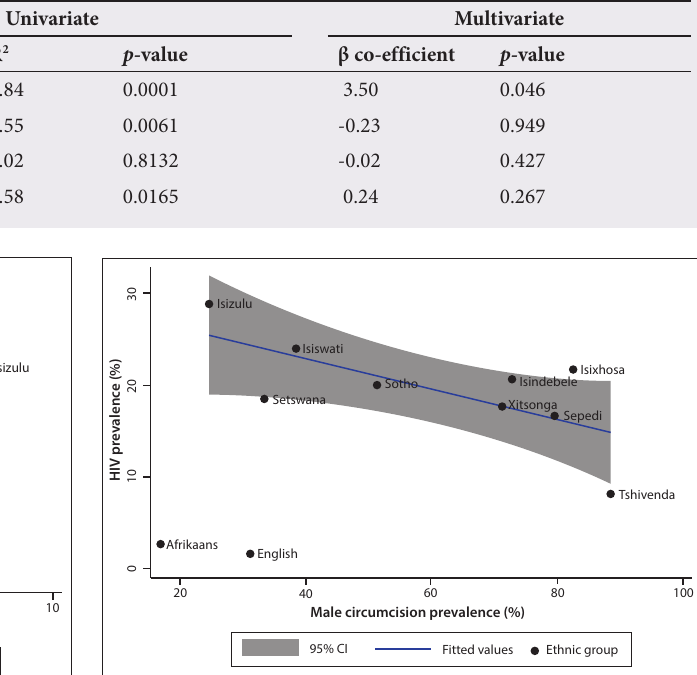
Fig. 2. Association between HIV prevalence (derived from SABSSM III) and the prevalence of male circumcision (derived from NCS 2009), for 11 language groups in South Africa ( R 2 =-0.02; p =0.70 for all 11 language groups and R 2 =0.48; p =0.04 when analysis restricted to the nine black language groups).